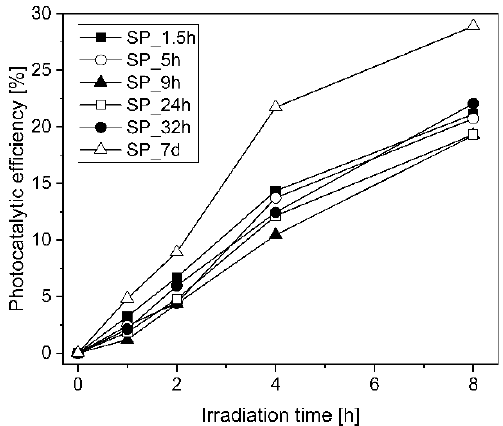
Figure 4. The influence of the TiO 2 coating time gap on the photocatalytic efficiency.